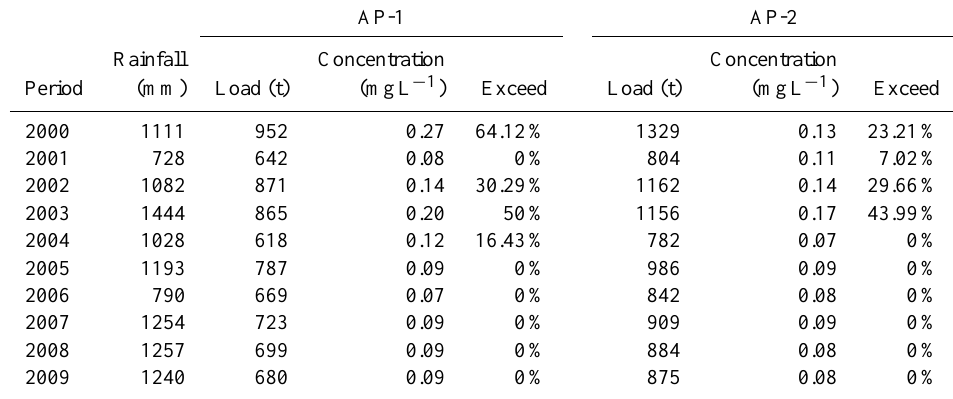
Table 1. The TP load reduction requirements at the Wuxi station and the watershed outlet during the period of 2000 to 2009. AP-1 AP-2 Rainfall Concentration Concentration Period (mm) Load (t) (mgL − 1 ) Exceed Load (t) (mgL − 1 ) Exceed 2000 1111 952 0.27 64.12% 1329 0.13 23.21% 2001 642 0.08